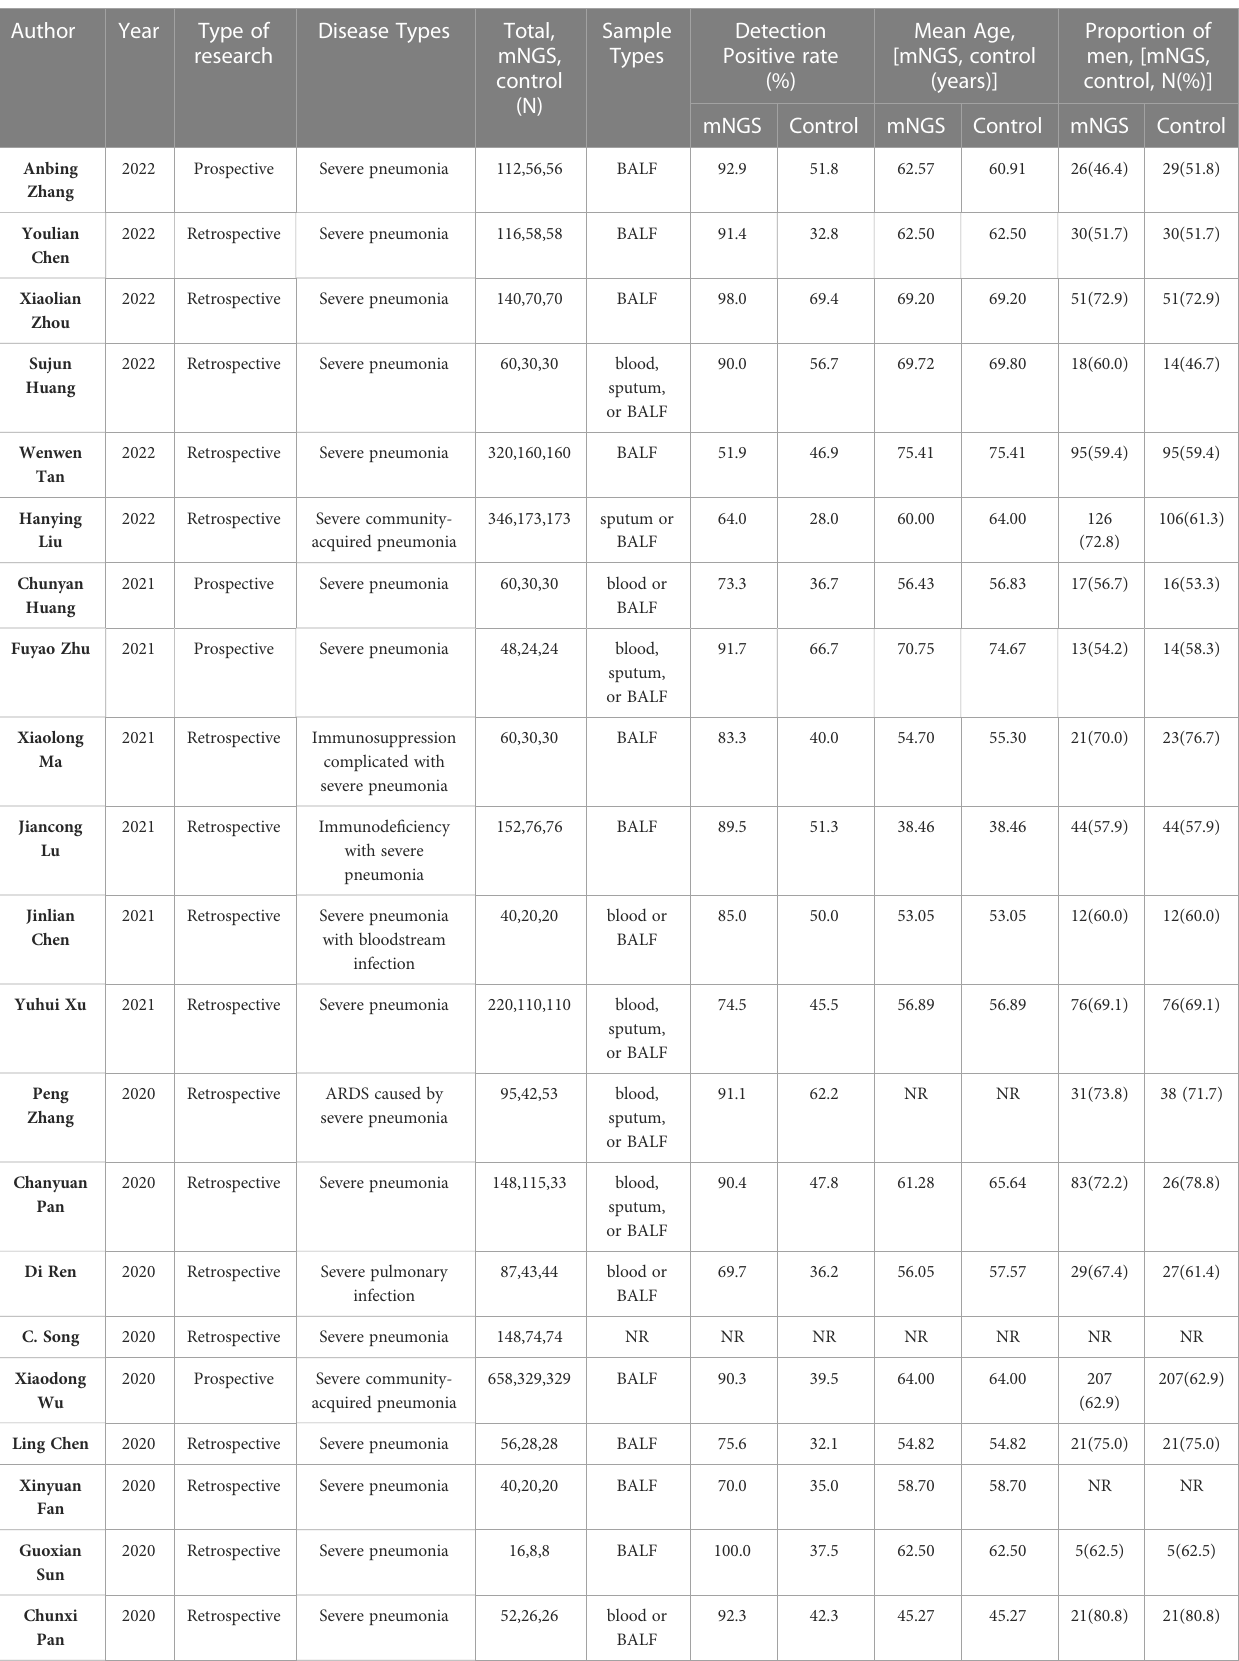
TABLE 1 The characteristics of the included preclinical